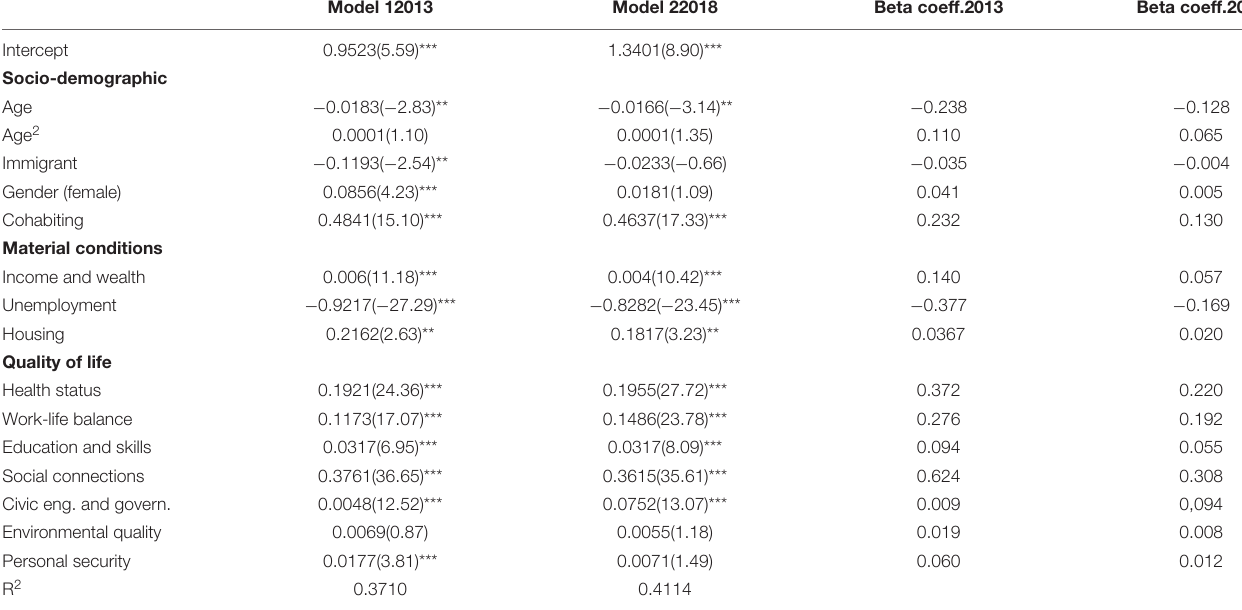
TABLE 2 | Drivers of SWB in 2013 and